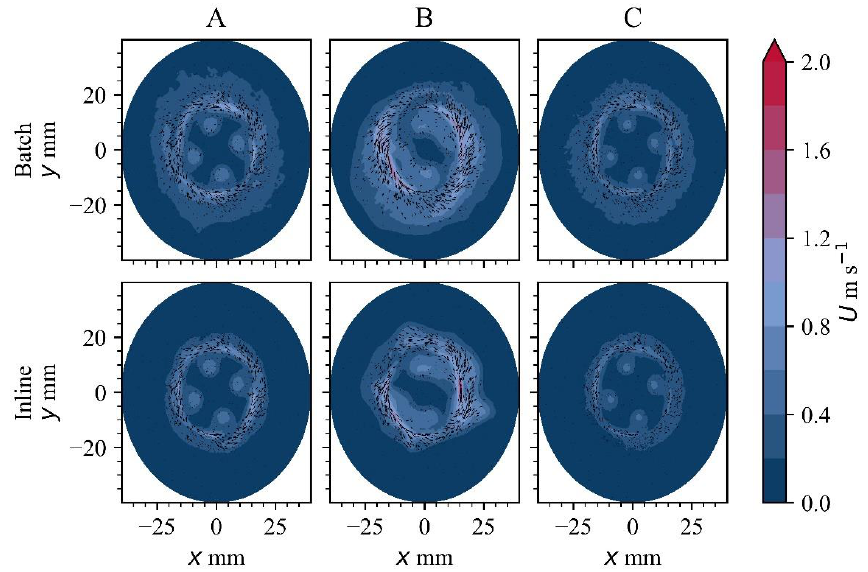
Figure 5. Velocity contours and arrows along a slice 1 mm below the mixer, corresponding to z = − 1 mm.